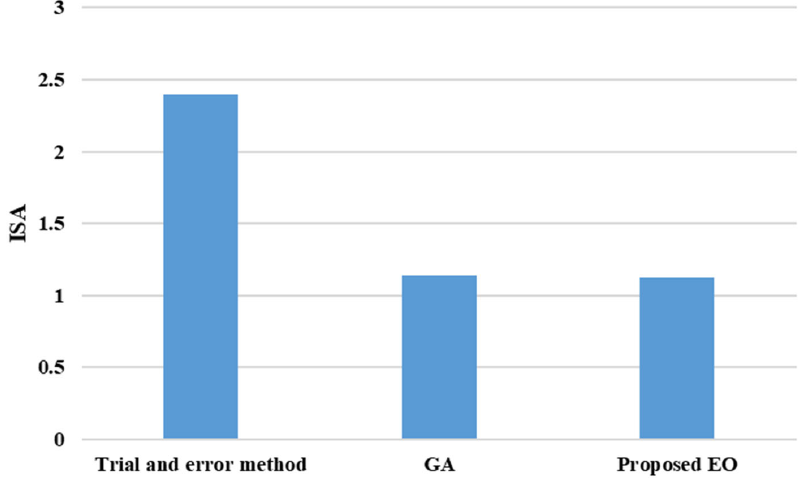
Figure 9. Integral square error values from simulation with and without the EO method. Table 4. ISE values in the case of the proposed EO and different techniques in literature.